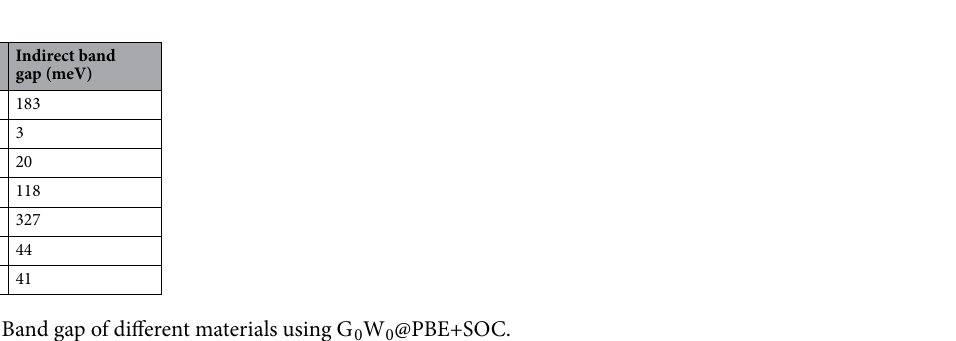
Figure 3. Phonon band structures of ( a ) GaBiSe 2 and ( b ) PbBiSe 2 .